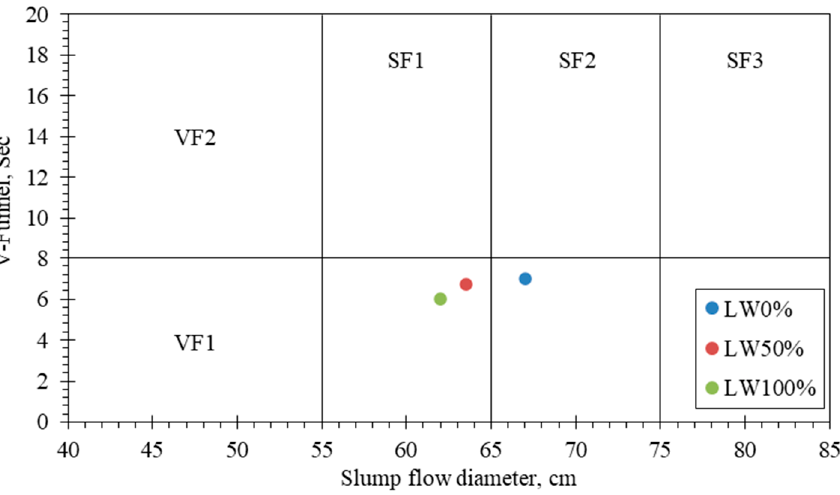
Figure 5. Processing window for SCC produced by LWA.